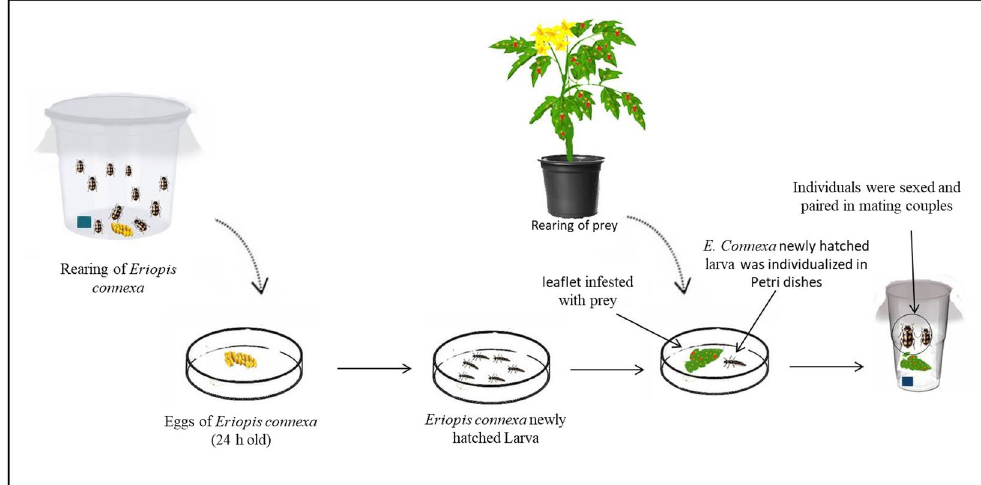
Figure 1. Experimental set up of Eriopis connexa reared on Tetranychus evansi . The same experimental set up was followed for the experiments of Eriopis connexa on Tetranychus urticae , Tetranychus ogmophallos and M. persicae. Number of replications =